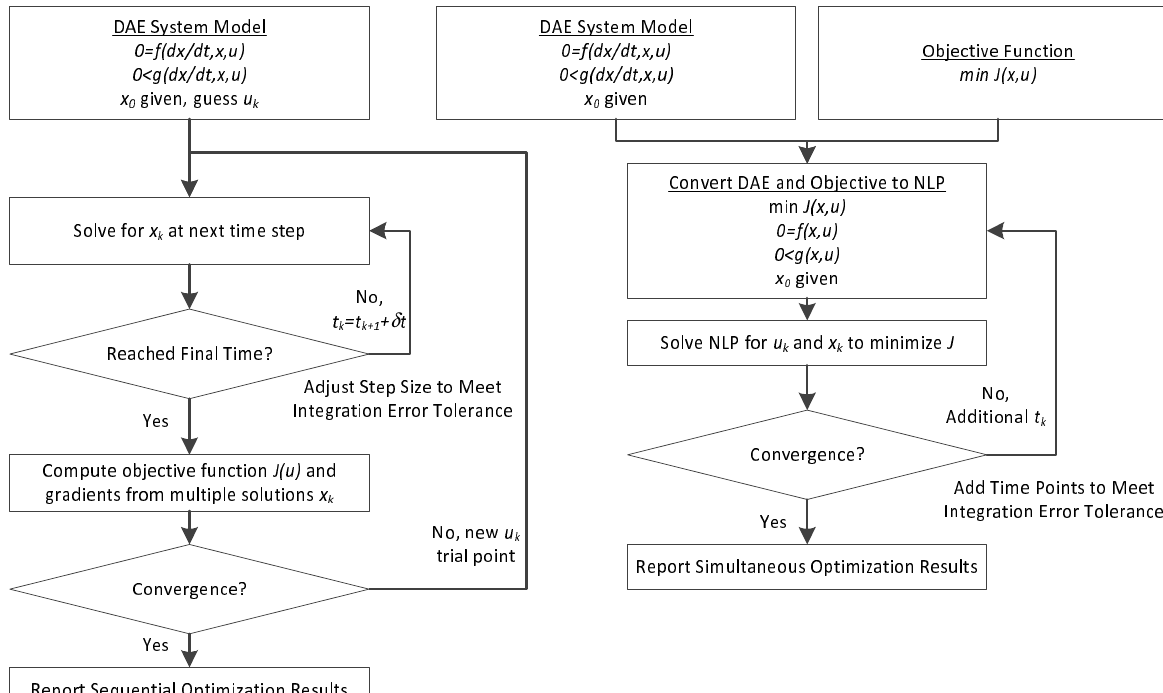
Figure 5. Overview of sequential ( left ) and simultaneous (right) approaches to optimize DAE systems.